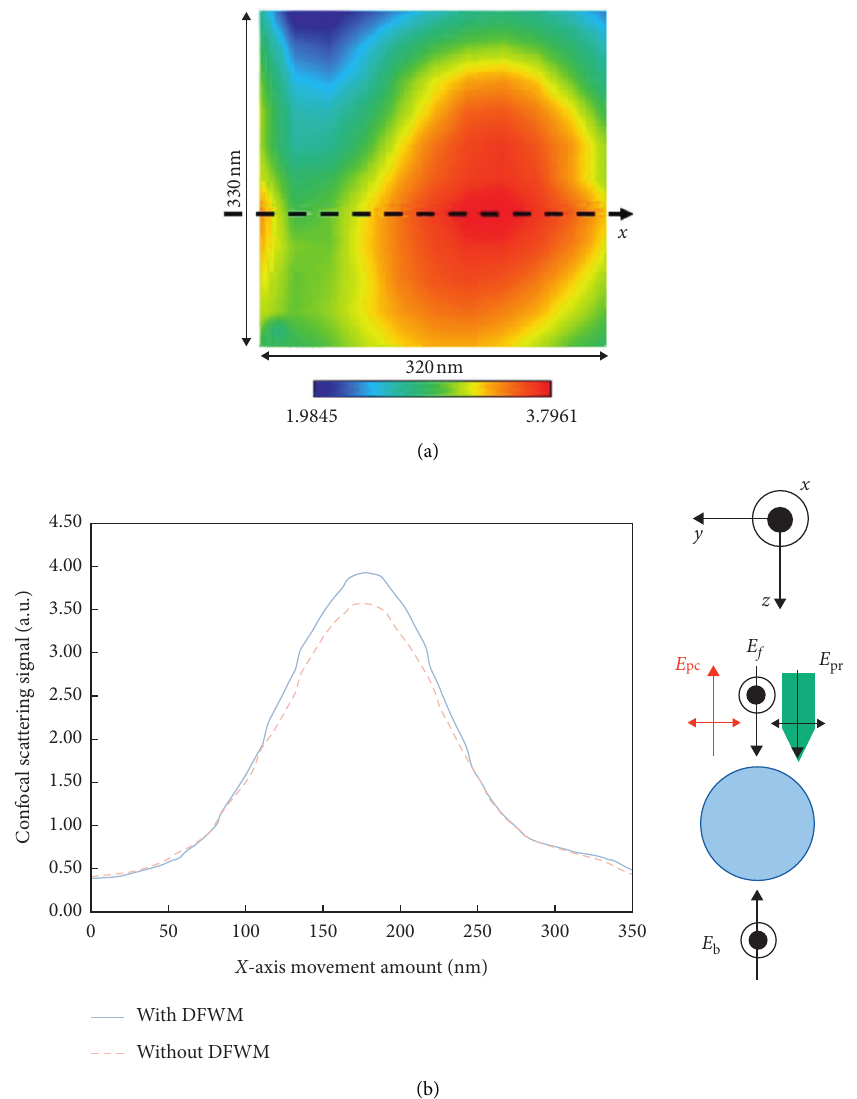
Figure 7: (a) Tomographic image of two dimensionally arranged PE-dye-doped polystyrene. (b) Confocal scattering signals from nanoparticle with and without